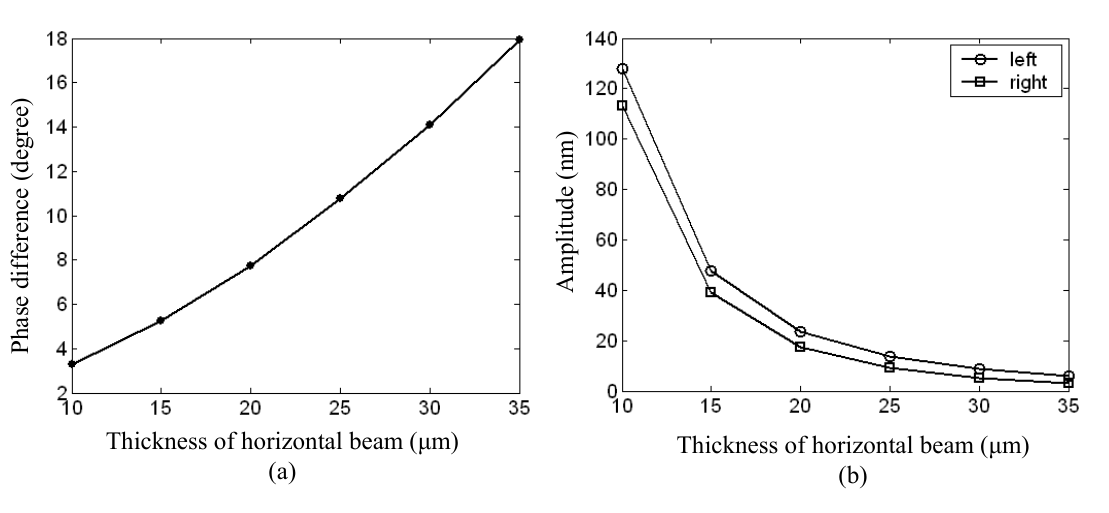
Figure 7. Phase difference (a) and amplitude of center point (b) versus the thickness of vertical beam.